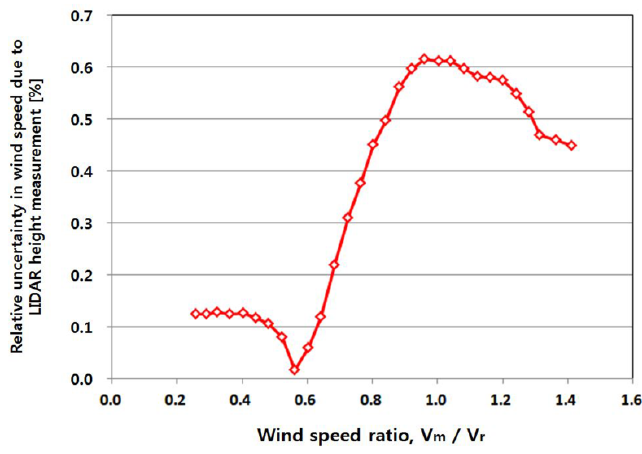
Figure 6. Relative uncertainty in wind speed due to variation in nacelle LIDAR measurement height.